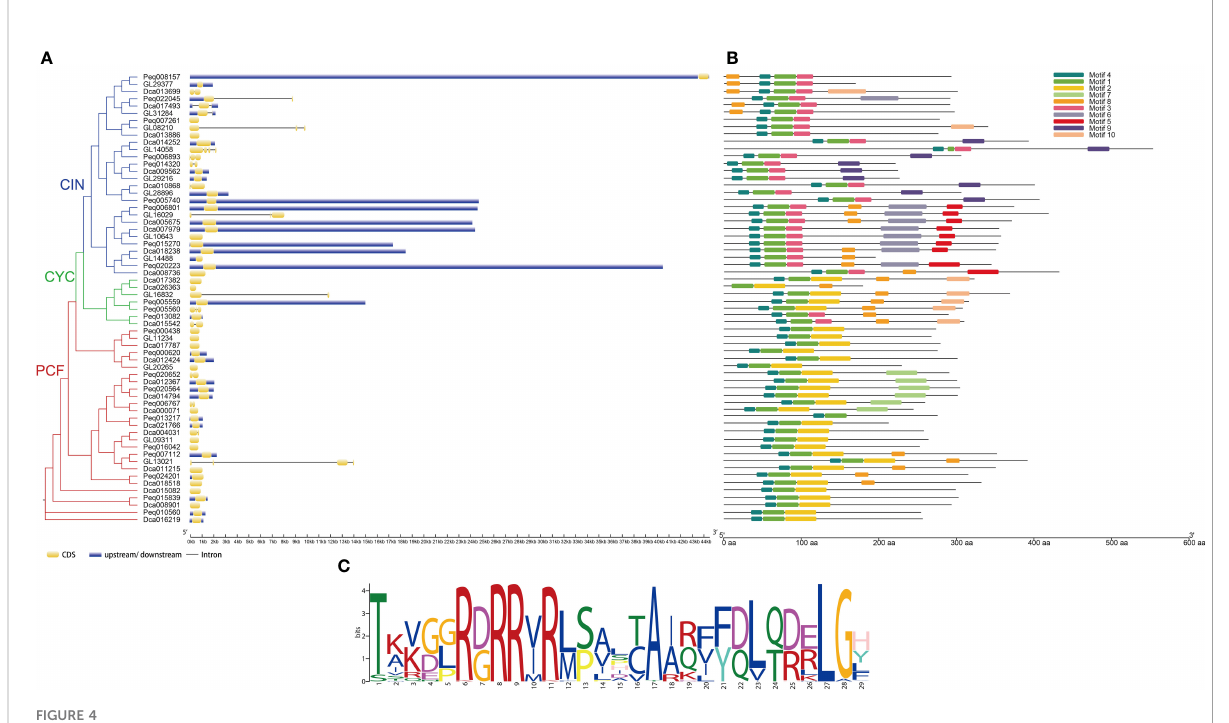
FIGURE 4 Gene structure, conserved motifs, and conserved domains of TCP genes. (A) Phylogenetic tree and gene structure of the TCP genes of C. goeringii , P. equestris and D . catenatum . (B) Predicted motifs of the TCP genes of C. goeringii , P. equestris and D . catenatum . (C) Sequence logo of motif 1, which encodes the TCP